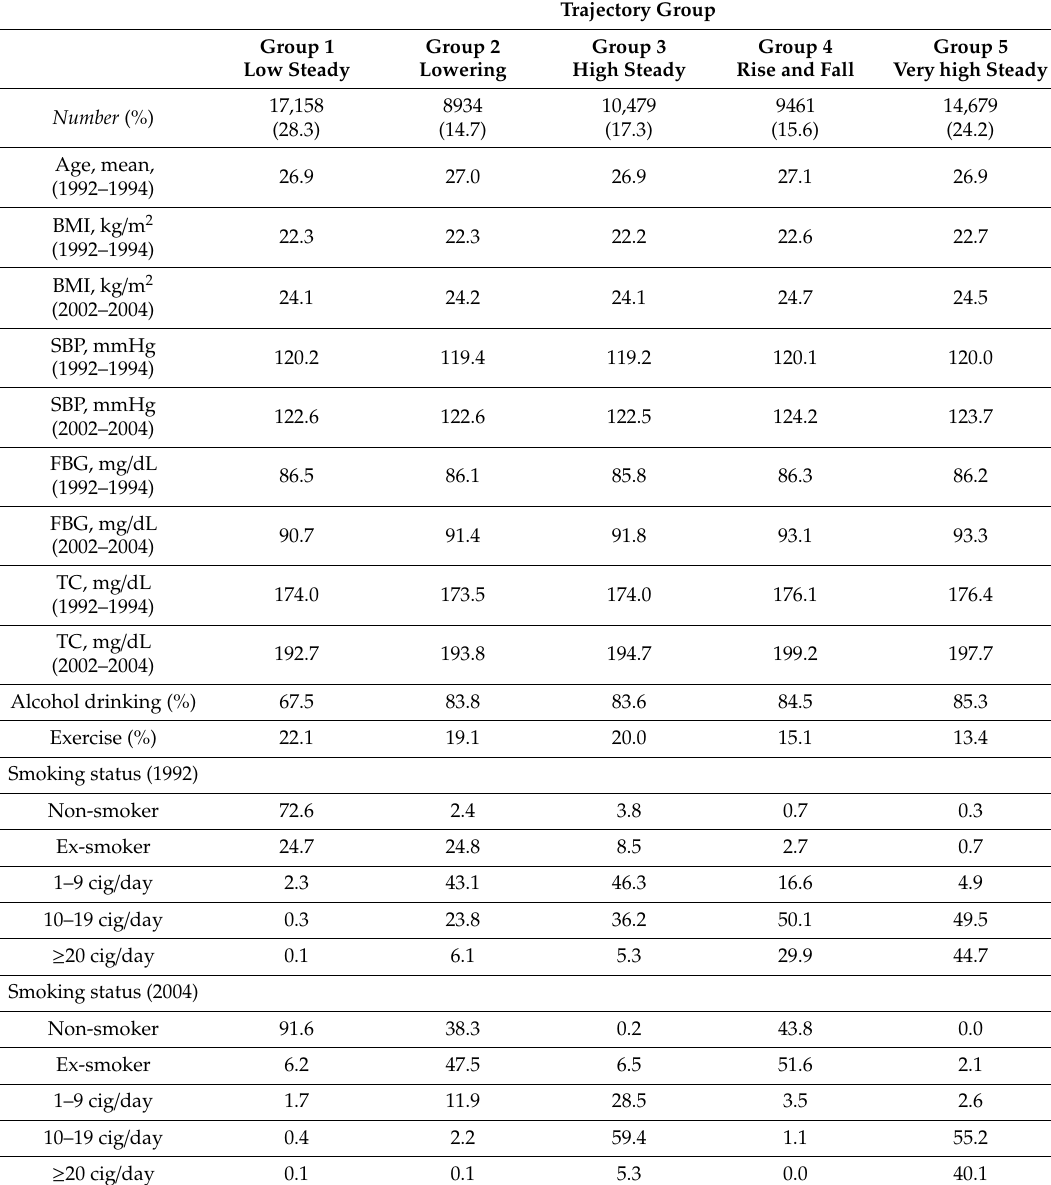
Table 1. General characteristic of study participants, according to trajectory